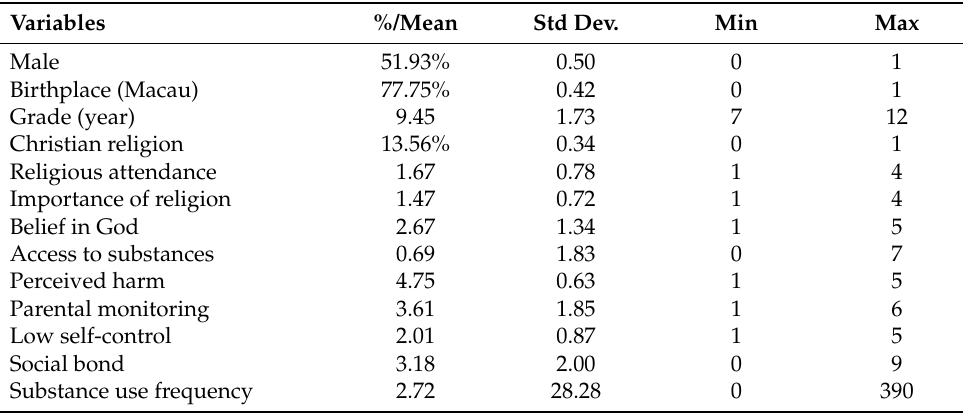
Table 1. Descriptive analysis of key variables ( N =